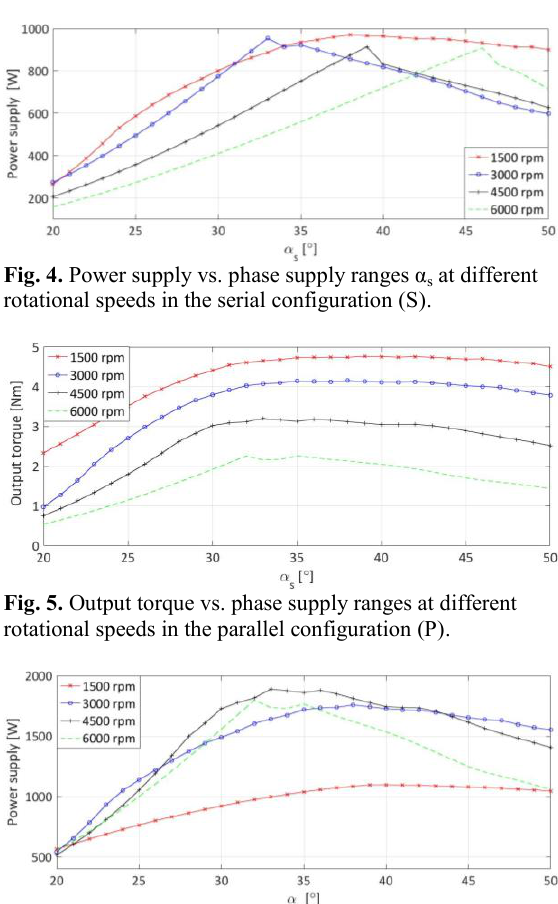
Fig. 6. Power supply vs. p hase supply ranges α s at different rotational speeds in the parallel configuration